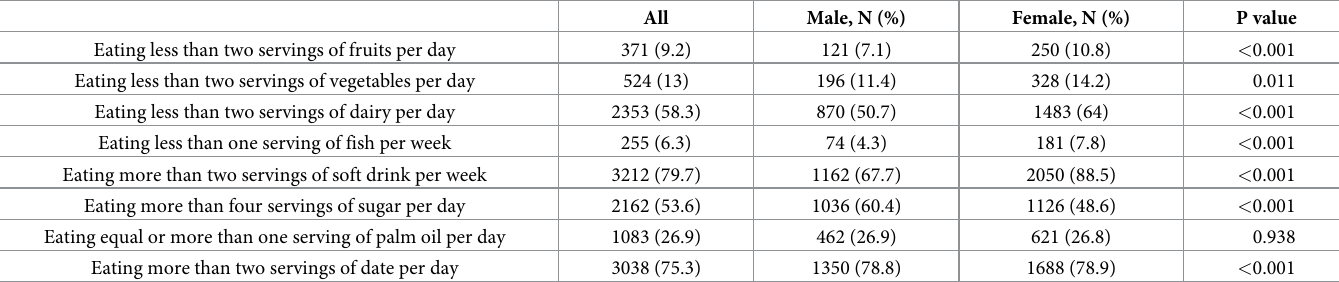
Table 10. Baseline dietary intake of participants in Bandar Kong cohort